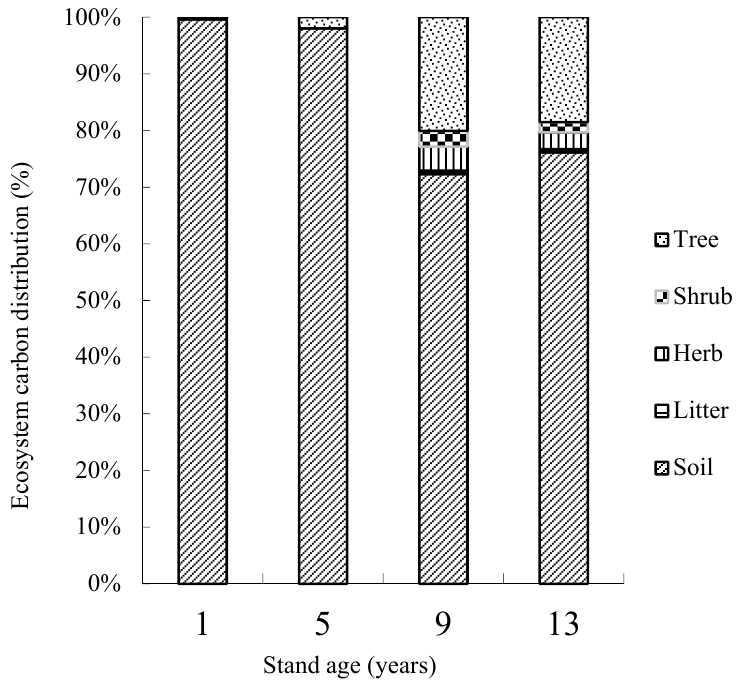
Figure 3. Percentage distribution of ecosystem C storage in J. regia plantations of four different ages.